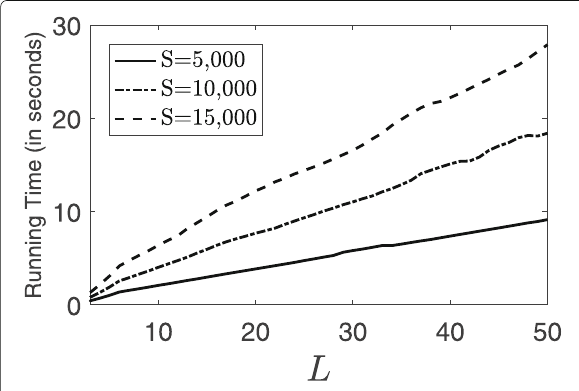
Fig. 9 Processing time required for implementing the OBKS for the target tracking example relative to the size of the window L and the number of MCMC samples S